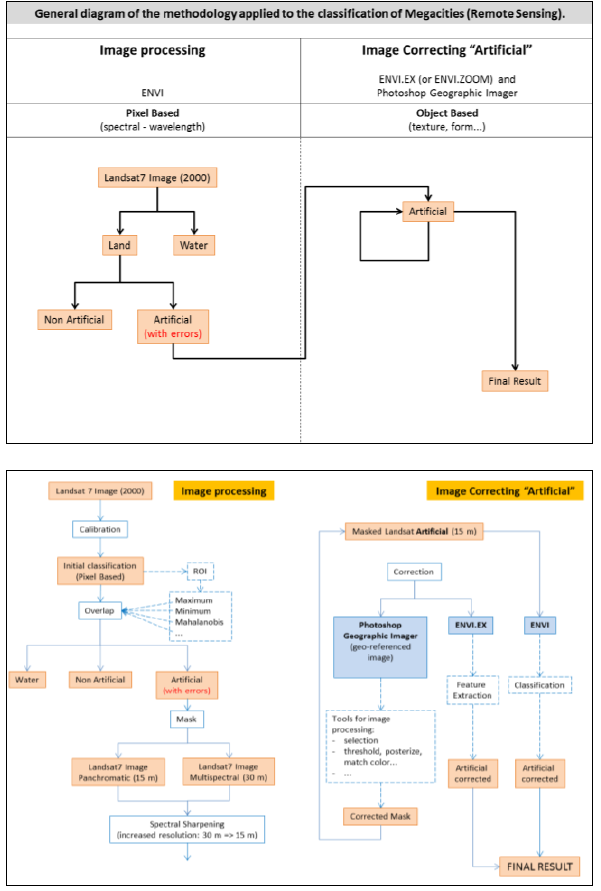
Figure 3.General Diagram of the